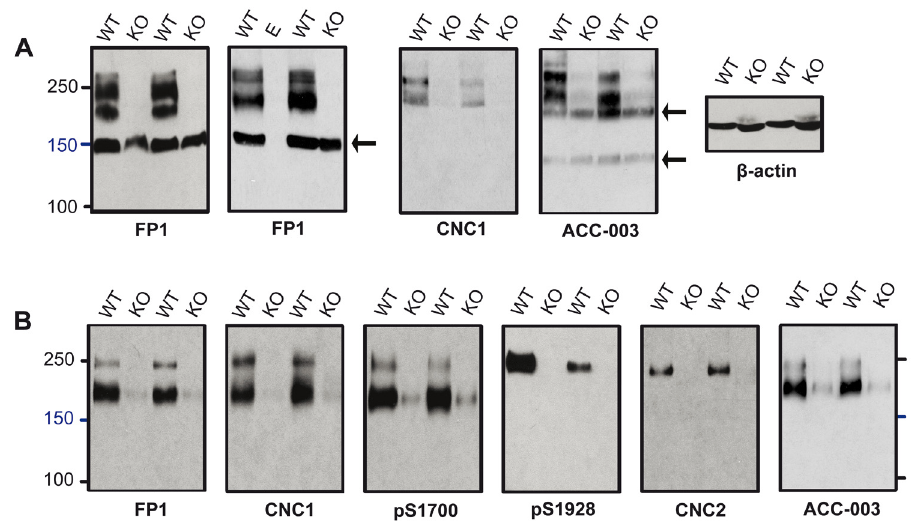
Figure 2. Determination of antibody specificity for α 1.2 with conditional α 1.2 KO mice. ( A ) Immunoblots of Triton X-100 extracts 1 1 from conditional α 1.2 KO mice (KO) and litter matched WT mice using gels polymerized from 8% acrylamide. To ensure that there was 1 no spill-over between lanes, in some gels one or more lanes were left empty as shown here for the middle lane labeled E in the right FP1 blot. To fully resolve α 1.2 short and long forms, the 100 kDa marker was run close to the bottom except in the right panel. In this 1 experiment, electrophoresis of the same extracts used for α 1.2 immunoblotting was terminated before the dye front reached the bottom. 1 Probing for β -actin showed that comparable amounts of protein were present in each extract from the different WT and KI mice. ( B ) Ca 1.2 v was immunoprecipitated from brain extracts from conditional KO and WT mice with the FP1 antibody before SDS-PAGE in gels polymerized from 6% acrylamide and immunoblotting with the indicated antibodies. To fully separate α 1.2 short and long forms, electrophoresis was 1 performed until the 100 kDa marker was near the bottoms of the gels. For all antibodies, the ~210 and 250 kDa bands were nearly or completely absent in cKO